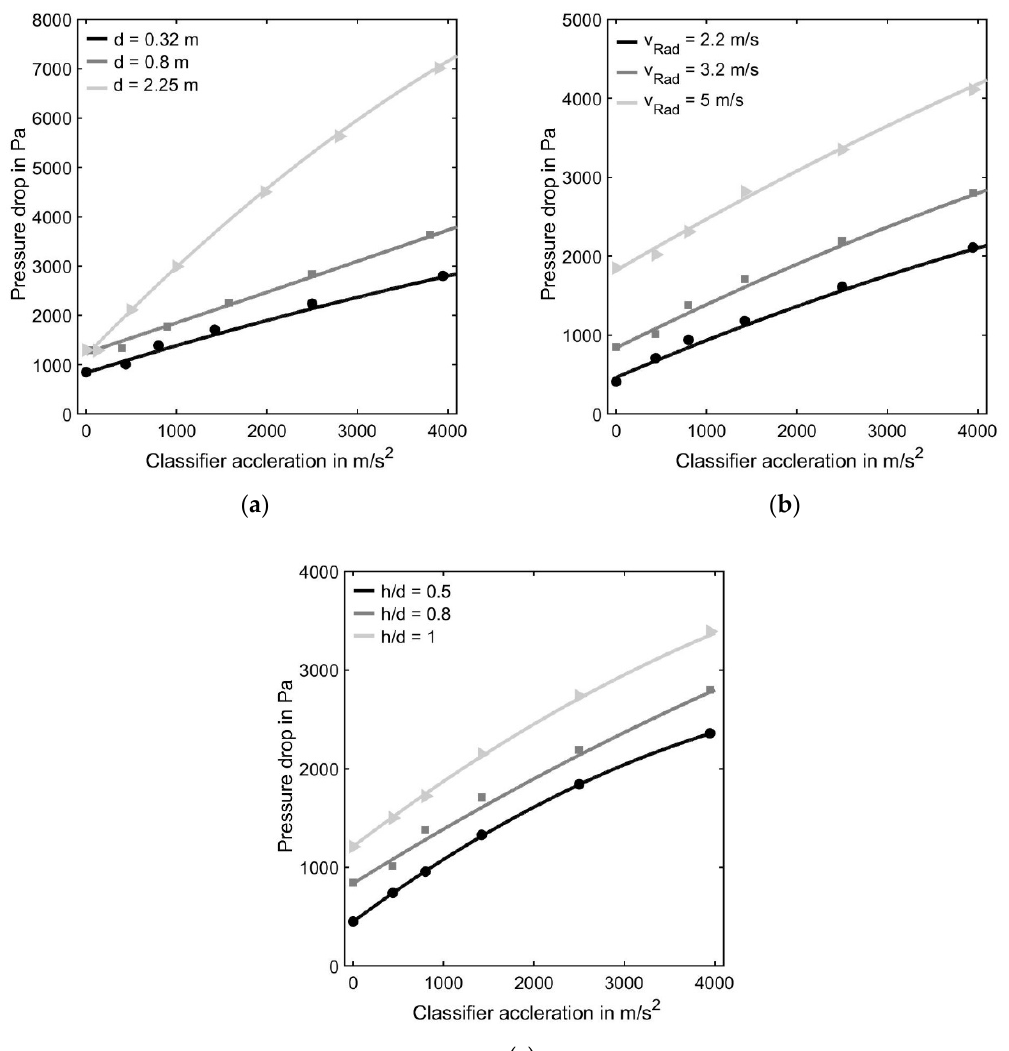
Figure 4. The corrected pressure loss from the numerical calculation as a function of ( a ) acceleration and classifier diameter, ( b ) acceleration and radial velocity and ( c ) acceleration and height to diameter ratio.